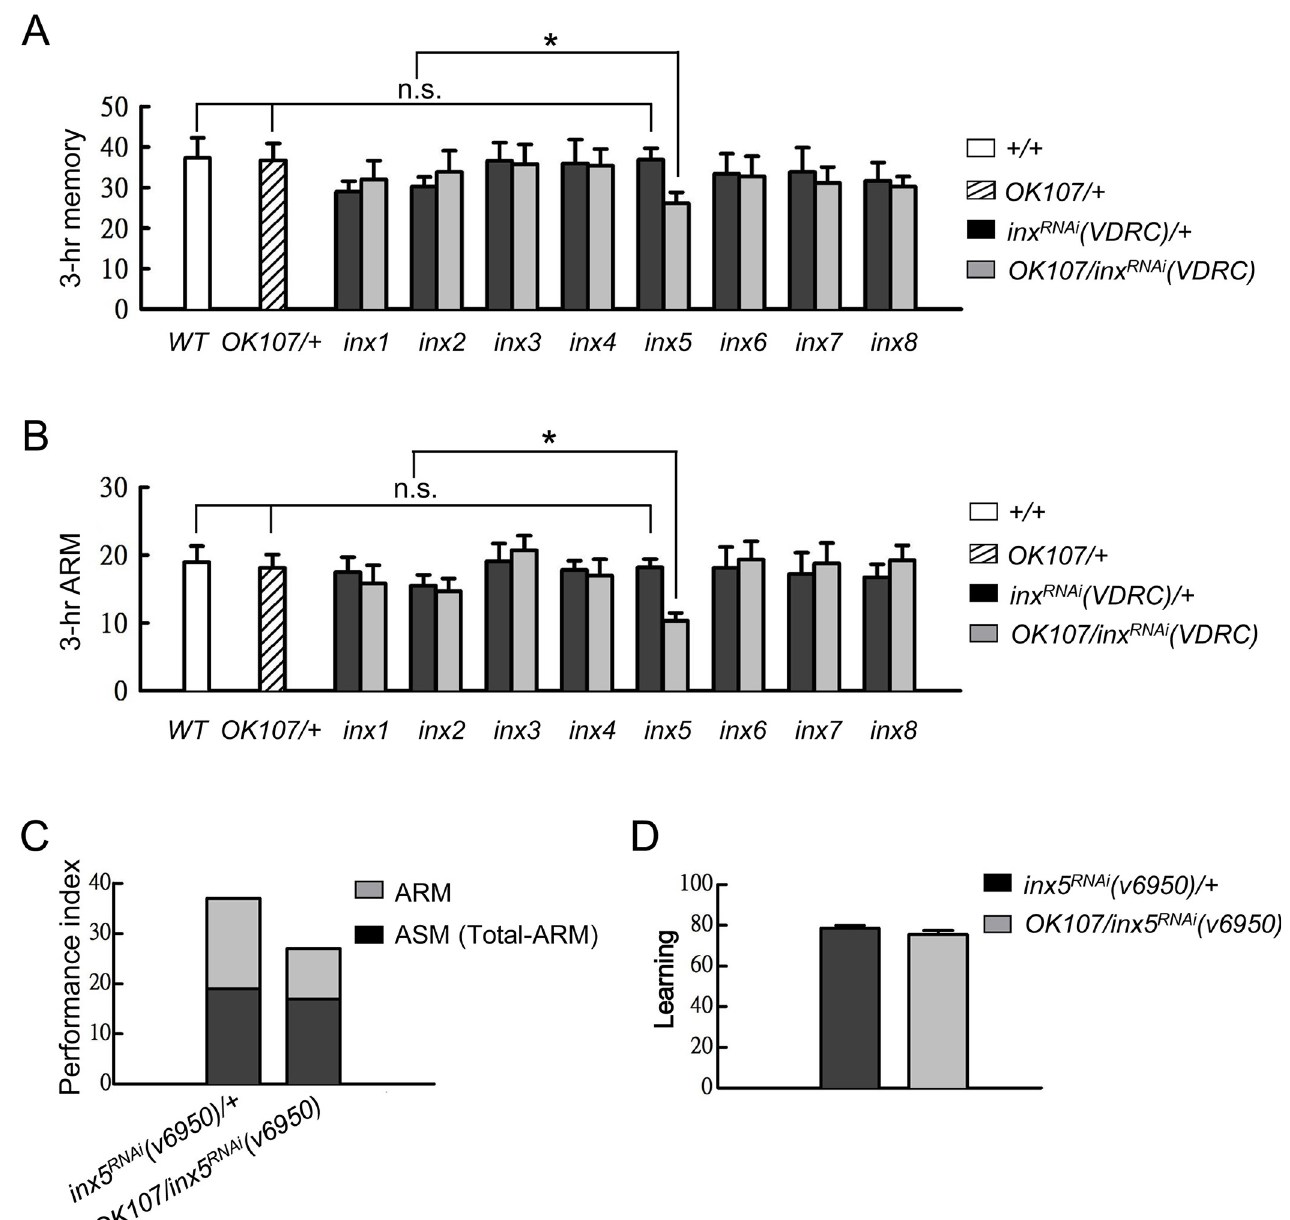
Fig 1. Downregulation of INX5 in MBs impairs ARM. (A) Three-hour memory (performance index) in flies carrying one of the eight UAS-inx RNAi (Vienna Drosophila Resources Center, VDRC) effectors driven by OK107-GAL4 . Each value represents the mean ± SEM (n = 8). n.s.: not significant (p > 0.05); � , p < 0.05; one-way analysis of variance (ANOVA) followed by Tukey’s test. The VDRC stock numbers for the UAS-inx RNAi effectors were as follows: UAS- inx1 RNAi (v103816), UAS-inx2 RNAi (v102194), UAS-inx3 RNAi (v39094), UAS-inx4 RNAi (v33277), UAS-inx5 RNAi (v6950), UAS-inx6 RNAi (v46398), UAS - inx7 RNAi (v103256), and UAS-inx8 RNAi (v26801). The genotypes were as follows: (1) +/+ , (2) OK107-GAL4/+ , (3) +/ UAS-inx RNAi (VDRC), and (4) OK107-GAL4/ UAS-inx RNAi (VDRC). (B) Three-hour ARM tests were performed on flies carrying the OK107-GAL4 driver and an inx RNAi transgene (VDRC). The flies were trained and tested at 3-hour after training; the 2-min cold shock was applied at 2-hour post-training. Each value represents the mean ± SEM (n = 8–17). n.s.: not significant (p > 0.05); � , p < 0.05; ANOVA followed by Tukey’s test. The genotypes were as follows: (1) +/+ , (2) OK107-GAL4/+ , (3) +/ UAS- inx RNAi (VDRC), and (4) OK107-GAL4/UAS-inx RNAi (VDRC). (C) The score of ASM, calculated by subtracting ARM from the total 3-hour memory score, was similar to that in the control group, whereas the ARM score (light gray) was reduced in the test group, indicating that ARM was preferentially impaired by INX5 knockdown in MB neurons. The same data as in (A) and (B) are represented. (D) Initial learning was normal in the inx5 -manipulated flies. Each value represents the mean ± SEM (n = 8; p > 0.05, t-test). The genotypes were as follows: (1) +/+; UAS-inx5 RNAi (v6950)/+ , (2) +/+; UAS-inx5 RNAi (v6950)/+; OK107-GAL4/+